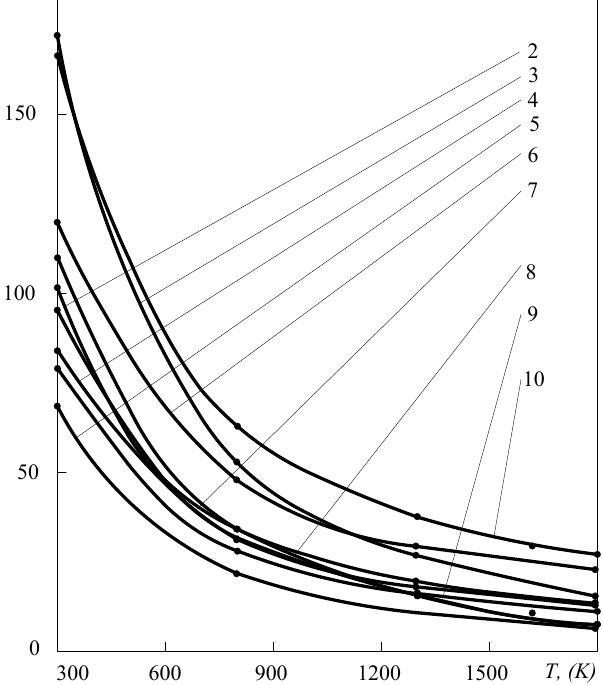
Figure 2. Effect of temperature reaction on lgk P,T with different forming products. 2—TiF 4 , 3—SiF 4 , 4—CaF 2 , 5—AlF 3 , 6—MnF 2 , 7—MgF 2 , 8—FeF 3 (from FeO), 9—FeF 3 (from Fe 2 O 3 ), 10—VF 5.